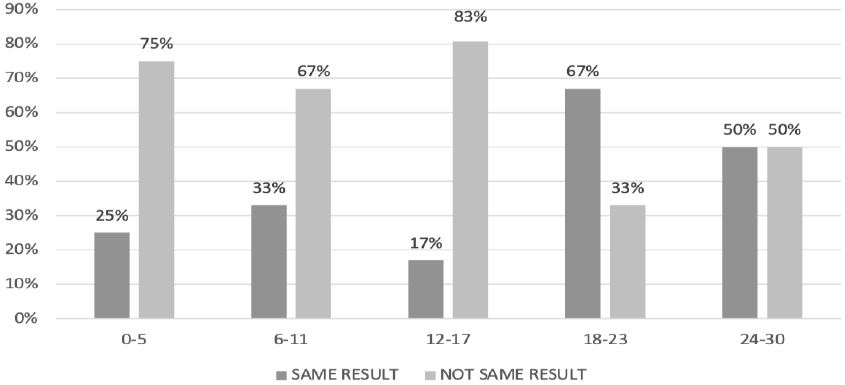
Figure 5. Agreement between laparoscopic and radiologic predictive index (PI) modified for inter- val debulking surgery (IDS).